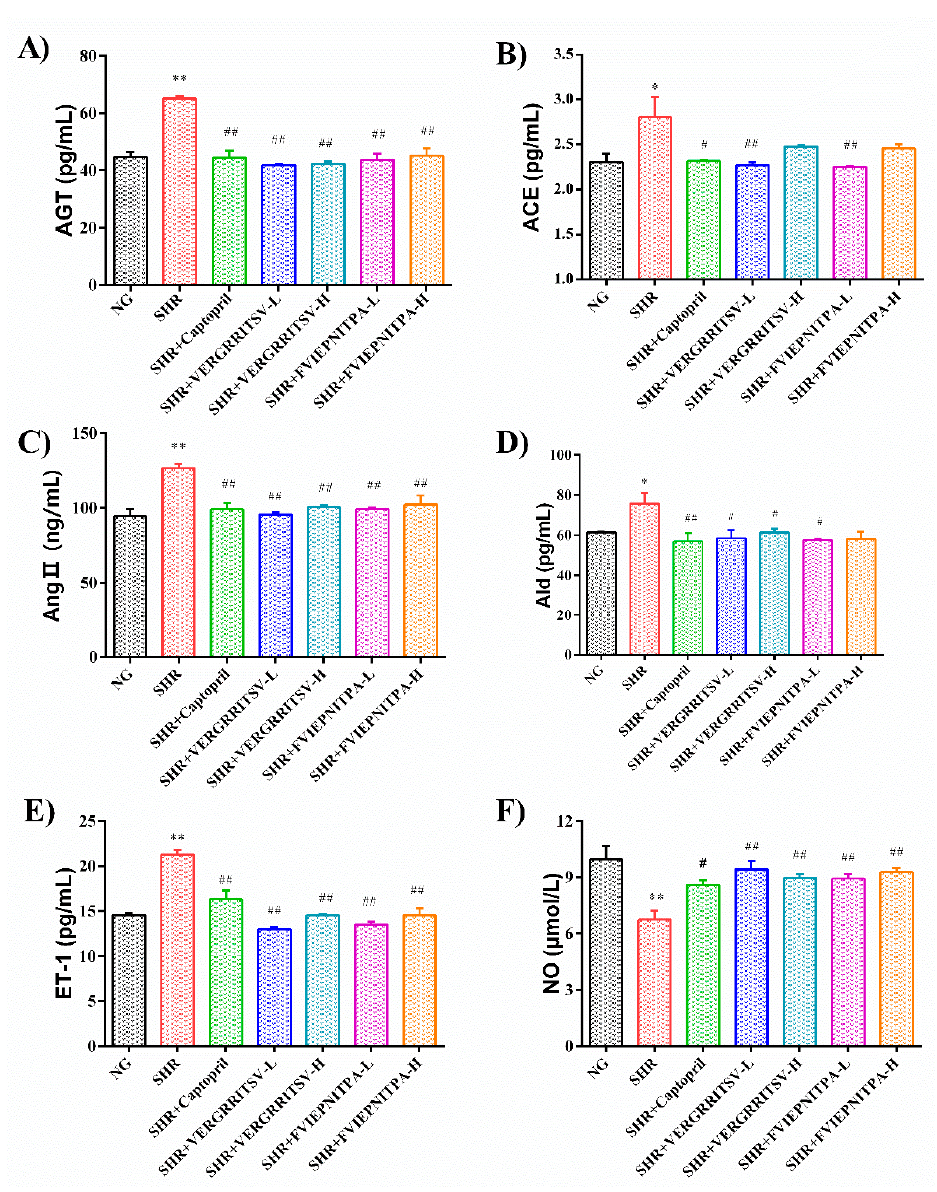
Figure 6. Effects of ACE inhibitory peptides of walnut glutelin-1 on serum AGT ( A ), ACE ( B ), Ang II ( C ), ALD ( D ), ET-1 ( E ), and NO ( F ) levels in SHR. * p < 0.05 and ** p < 0.01, vs. the normal group (NG). # p < 0.05 and ## p < 0.01 compared with the SHRs group.